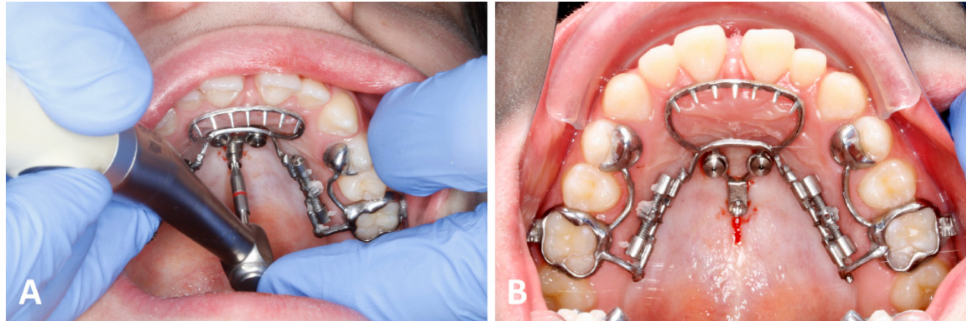
Figure 8. Direct screw insertion: ( A ) Implant placement with appliance itself serving as a guide. ( B ) Completed installation of the appliance from Figure 7 on two mini-implants (with fixation screws) and a posterior direct mini-implant inserted through the appliance